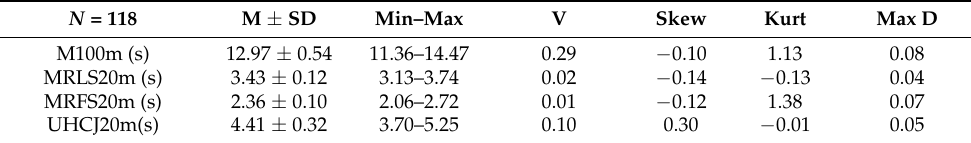
Table 1. Descriptive statistics of tests.